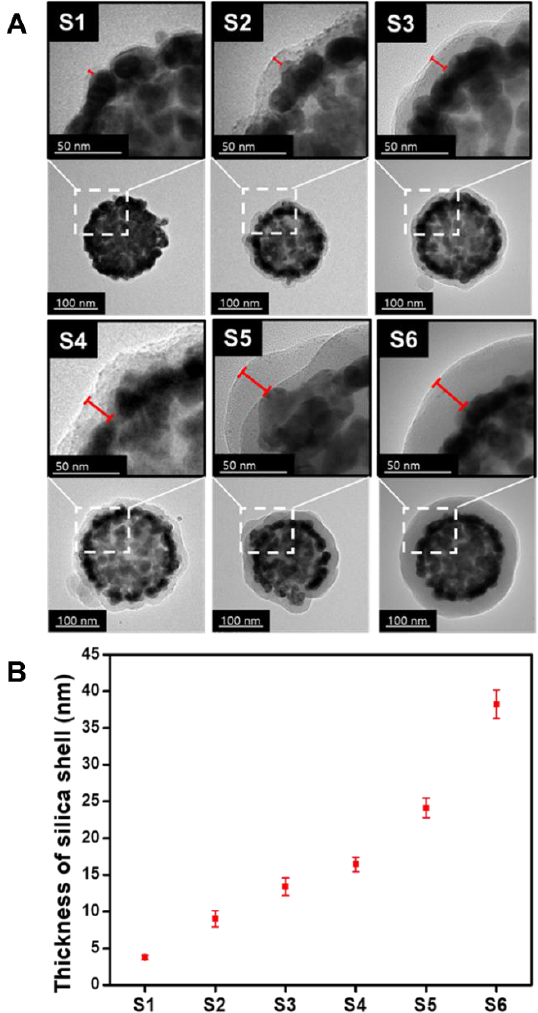
Figure 1. ( A ) Low- and high-magnification TEM images of SiO 2 @Ag@SiO 2 with various thicknesses of silica shell on the SiO 2 @Ag surface. ( B ) Thickness of the silica shell layer on the surface of the SiO 2 @Ag NPs synthesized under various conditions. S1, S2, and S3 were synthesized using SiO 2 @Ag (5 mg, 10 mg, and 20 mg, respectively) and Na 2 SiO 3 (14.4 µ L). S4, S5, and S6 were synthesized using 10 mg of SiO 2 @Ag (10 mg), Na 2 SiO 3 (14.4 µ L), and TEOS (1.2 mM, 2.3 mM, and 4.7 mM, respectively).